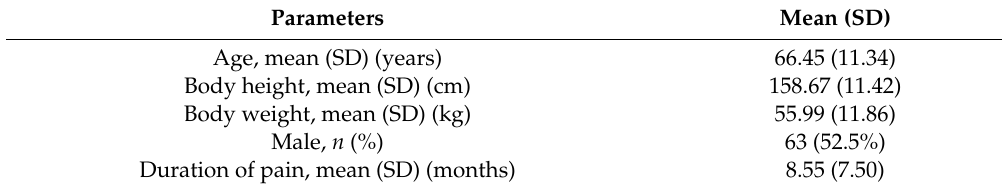
Figure 1. Clinical study flowchart. Table 1. Baseline characteristics of 120 patients suffering from PHN.